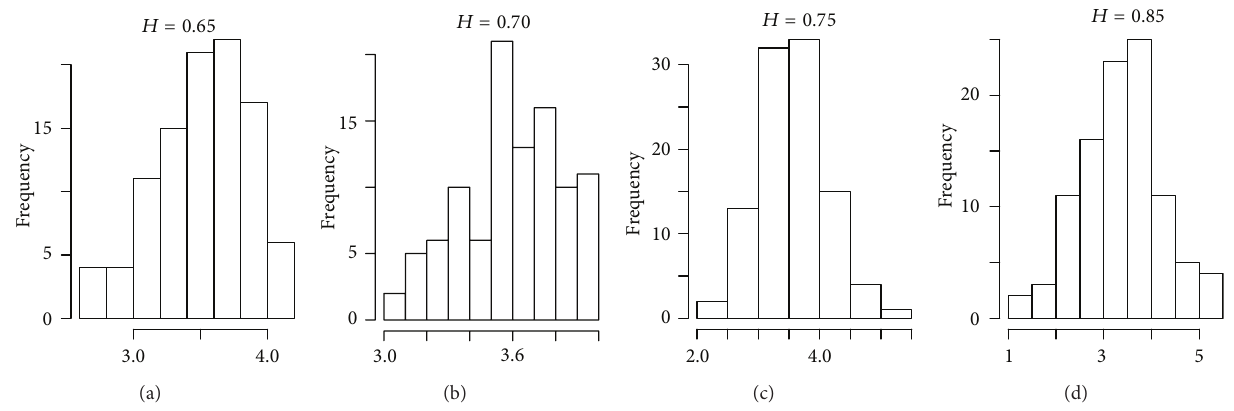
Figure 3: Histogram of the estimator ̂𝛼 ( 𝛼 = 3.5880 ) for different values of 𝐻 .